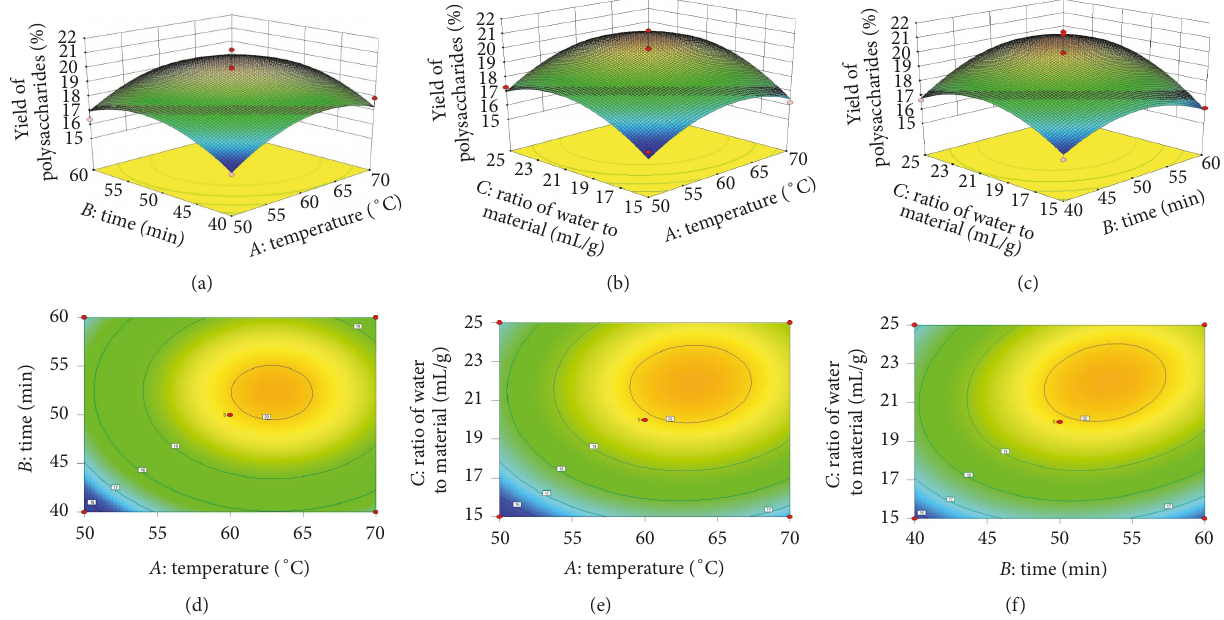
Figure 2: Response surface plots (a, b, and c) and contour plots (d, e, and f) showing the effect of time, temperature, and water-to-material ratio on yield of DDFPs.